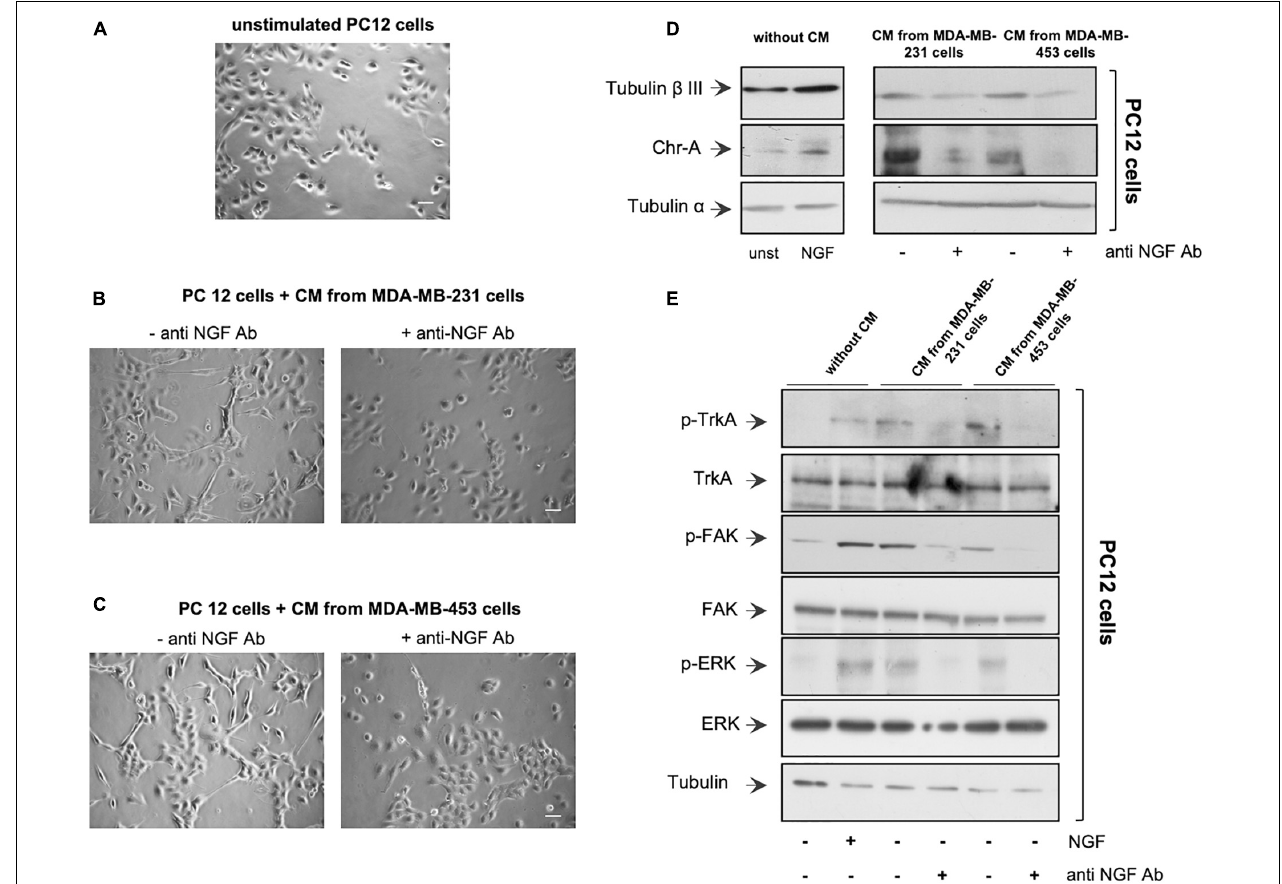
FIGURE 2 | Neurotrophin β -nerve growth factor (NGF) secreted by triple-negative breast cancer (TNBC) cells is biologically active. (A,B) PC12 cells were embedded in Matrigel and unchallenged (A) or challenged with conditioned media (CM) from MDA-MB-231 (B) or from MDA-MB-453 (C) cells ( left panels ) in the absence or presence of anti-NGF neutralizing antibody (anti-NGF; right panels ) for 6 days. Phase-contrast images are representative of three different experiments, each in duplicate. Scale bar , 10 µ M. (D,E) PC12 cells were unstimulated or stimulated for 72 h with 100 ng/ml NGF or CM from MDA-MB-231 and MDA-MB-453 cells unchallenged or challenged with anti-NGF. Lysate proteins from PC12 cells were analyzed by Western blot (WB) using the antibodies against the indicated proteins. WB are representative of three different